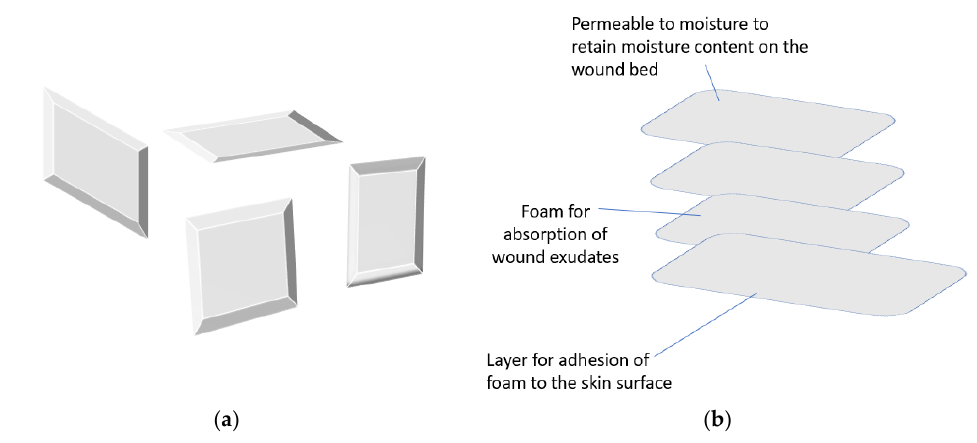
Figure 3. ( a ) Foam-based wound dressings, ( b ) Multi-layer foam.